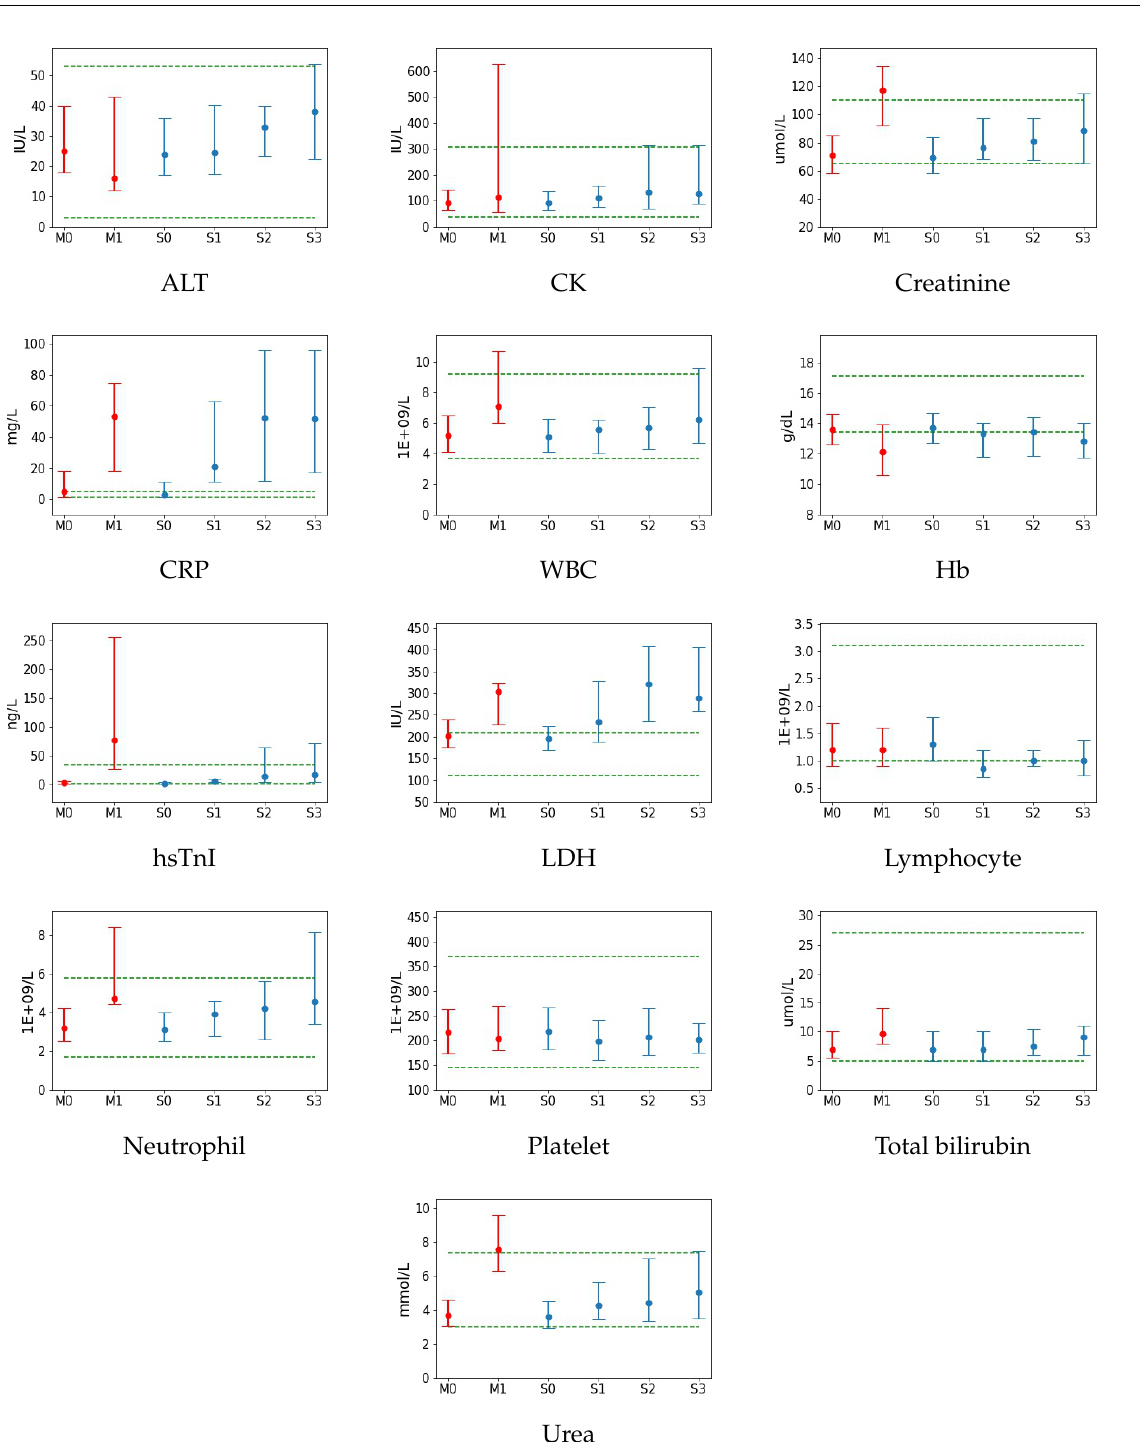
Figure 2. The median (dot) with the interquartile range (solid vertical lines) presented for each test result collected for patients categorized according to their Mortality (red) and Severity (blue) status. Dashed green lines represent the range of normality for the test